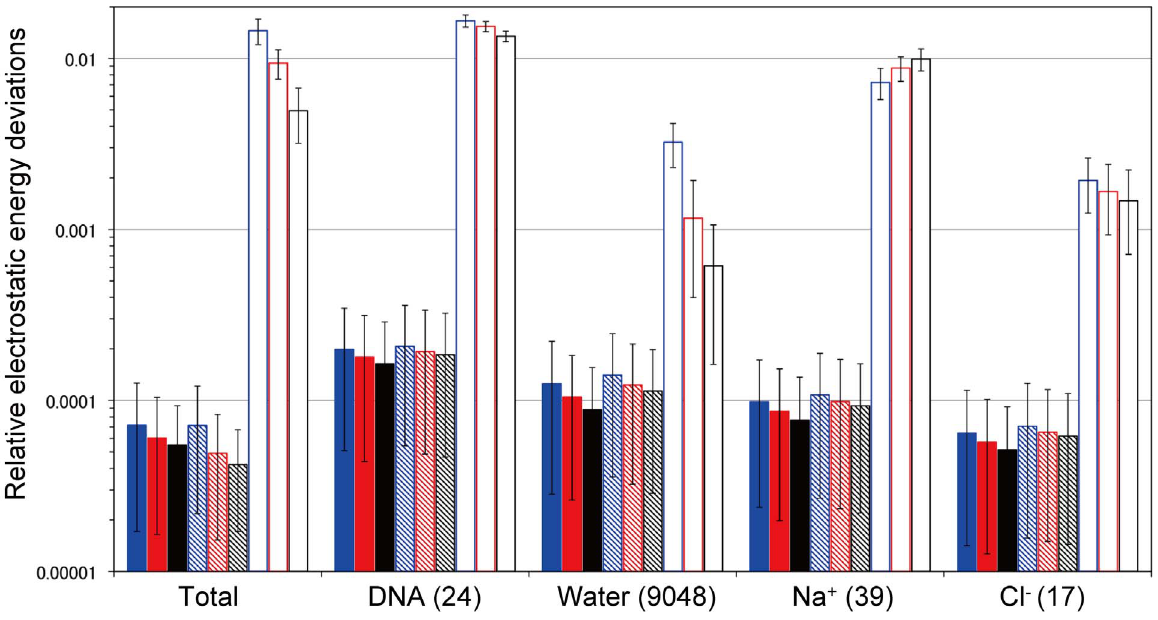
Figure 3. Relative individual contributions to electrostatic energy deviations by the ZD and RESA methods from the Ewald electrostatic energy, averaged for 1,000 sample structures produced by MD with the PME method (Eq. 9). Solid blue, red, and black bars are the contributions by the ZD method with the cutoff distance r c values = 12, 14, and 16 (A˚), respectively, and the damping factor a =0.0. Hatched blue, red, and black bars are those with r c =12, 14, and 16 (A˚), respectively, with a =0.1 (A˚ 2 1 ). Open blue, red, and black bars are those obtained by the RESA method with r c =12, 14, and 16 (A˚), respectively. The numbers in parentheses are the numbers of nucleotides in DNA, the numbers of water molecules, and the numbers of Na + and Cl 2 ions. The error bars are the standard deviations for 1,000 samples.